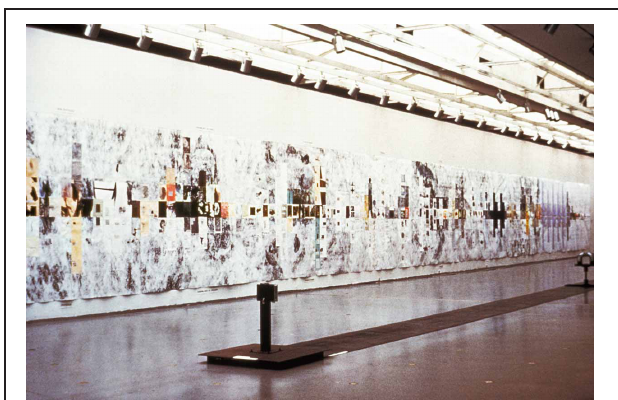
FIGURE 1 | “Thought-Assemblies,” 1979–1982. Installation view at Musee D’Art Moderne de la Ville de Paris, France, 1982. Mixed media on synthetic paper and canvas, 9 × 127ft. “Thought-Assemblies” details a process of incubating ideas and percolating on the possibilities of their actualization. This symbolic artwork draws on my formal studies of neuropsychology, which helped inform my visualizations of the creative